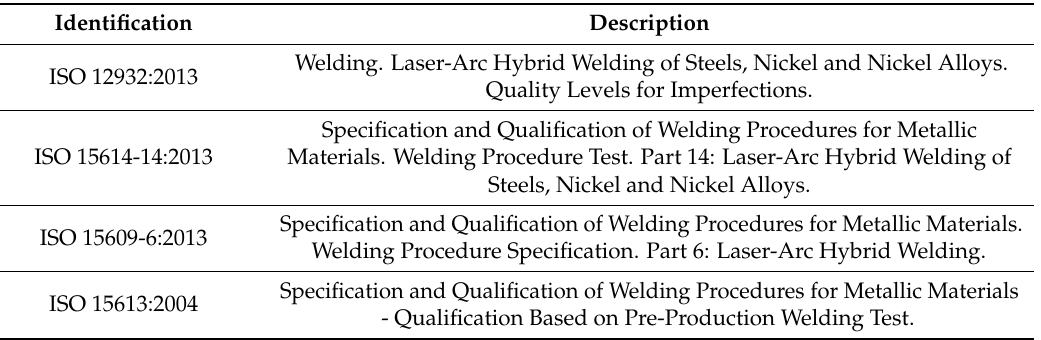
Table 1. LAHW Welding